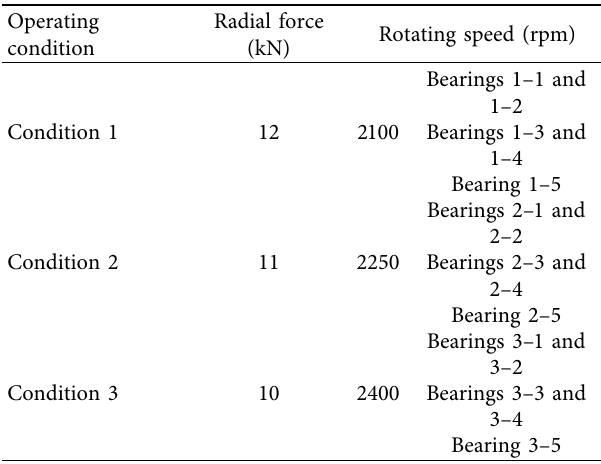
Figure 7: Bearing contact fatigue testing machine. Table 2: Details of bearing datasets